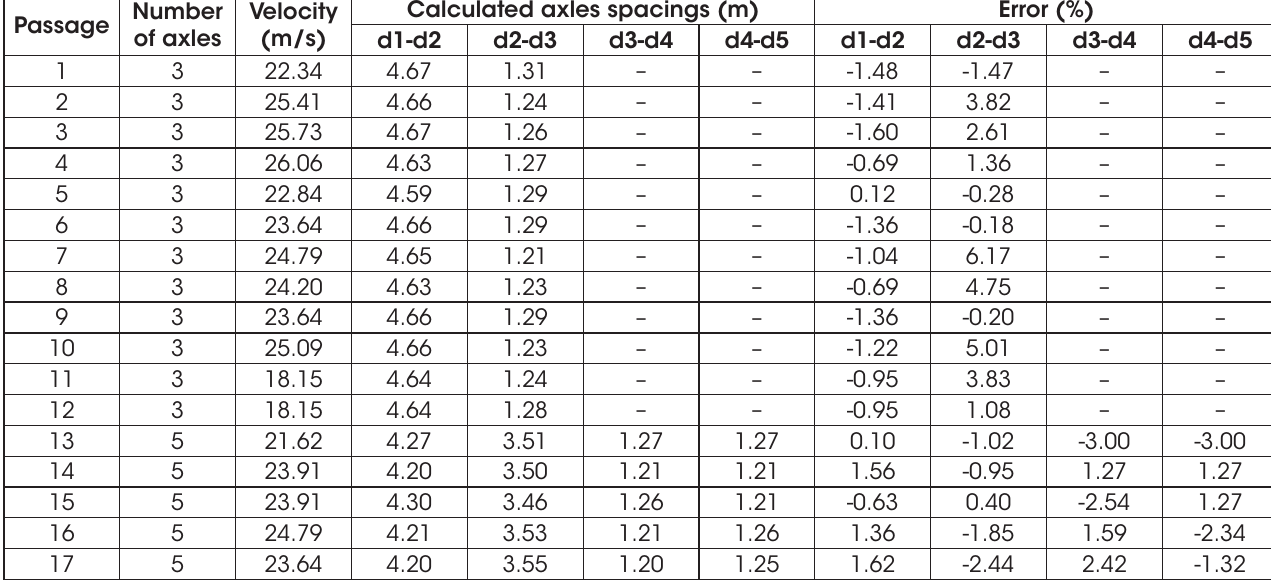
Velocities and axles spacings obtained with FAD sensors for lane 1 Number Velocity Passage of axles